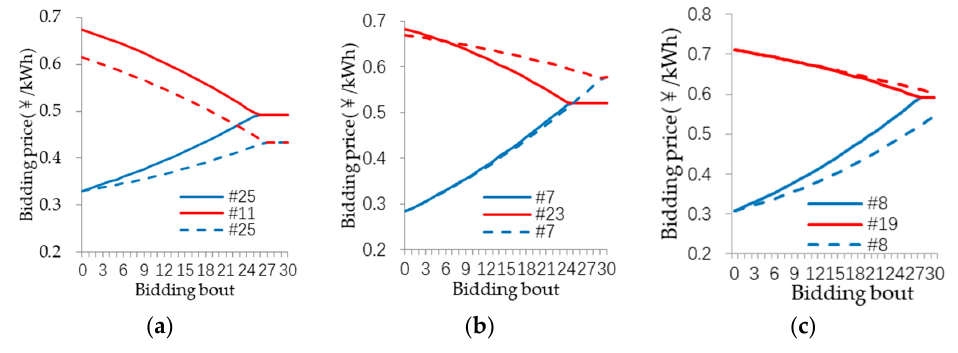
Figure 7. Price bidding process of three groups. ( a ) buyer A25; ( b ) buyer A7; ( c ) buyer A8. Table 2. Comparison of search strategies in three